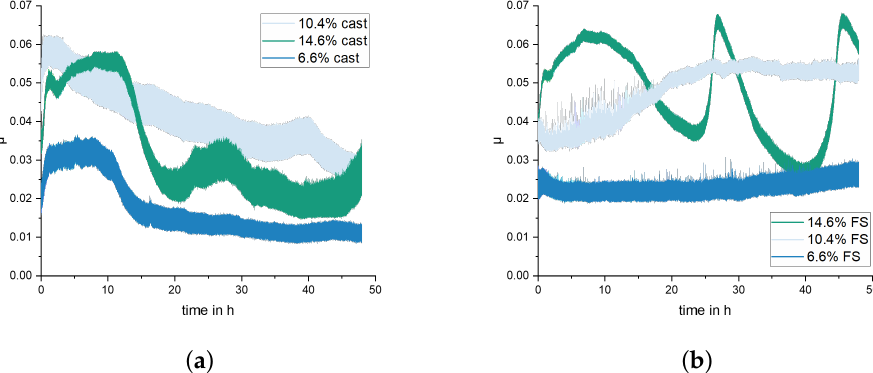
Figure 6. Coefficient of friction over test duration for ( a ) as-cast and ( b ) FS